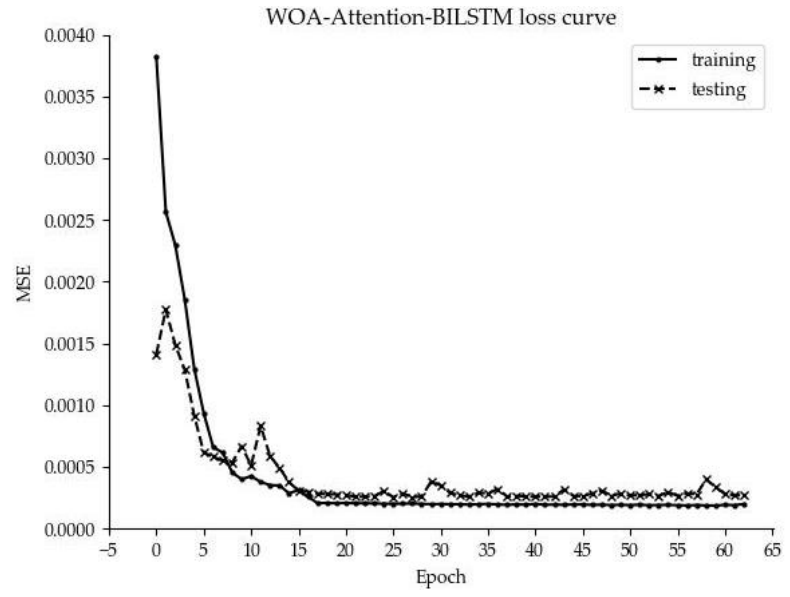
Figure 10. The loss curve of WOA-Attention-BILSTM model.